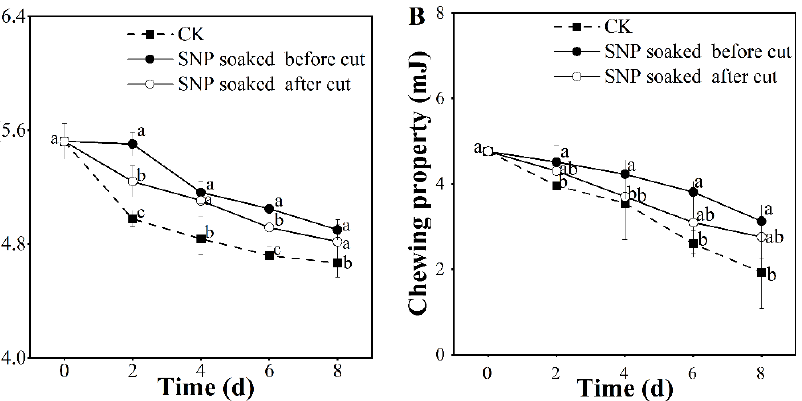
Figure 2. Effect of SNP treatment on texture of fresh-cut potatoes. Firmness ( A ) and chewing properties ( B ). Different letters indicate significant differences among treatments at same storage time ( p < 0.05).